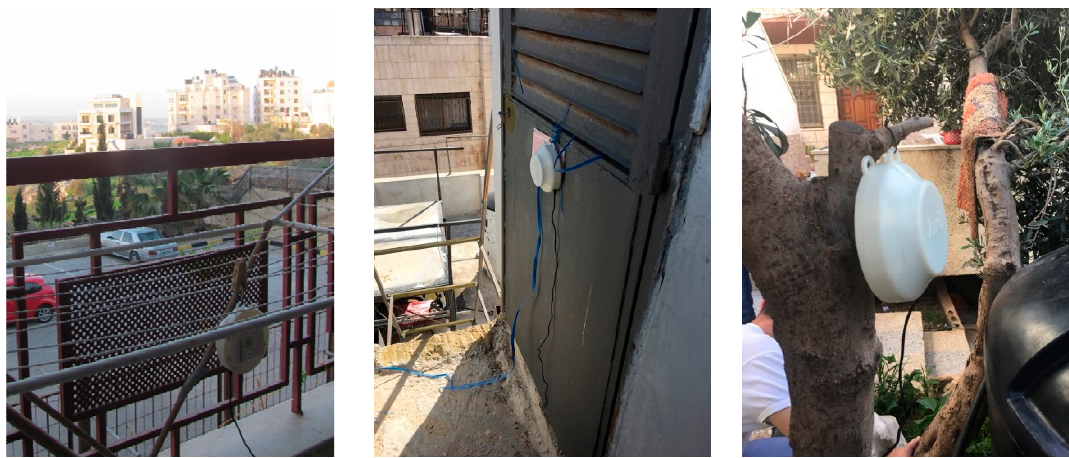
Figure 3. The AirU sensors as deployed at the first (SW), second (DT), and third (NE) sites, respectively.